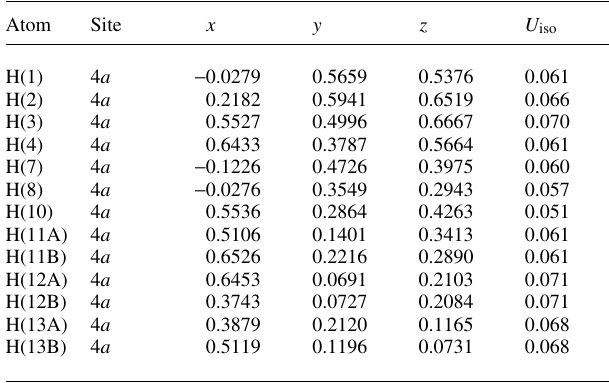
Table 2. Atomic coordinates and displacement parameters (in Å 2 )